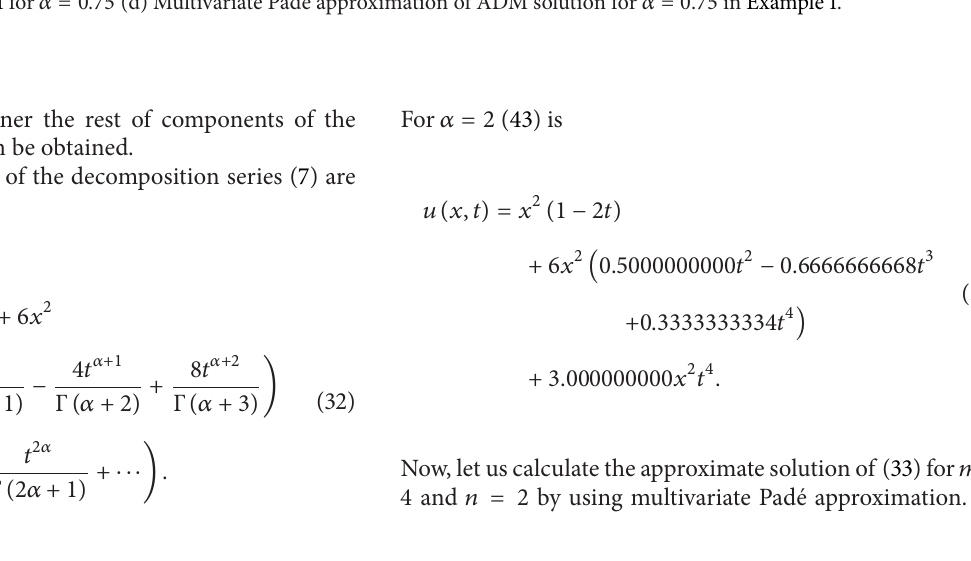
Figure 2: (a) ADM solution of Example 1 for 𝛼 = 0.5 (b) Multivariate Pad´e approximation of ADM solution for 𝛼 = 0.5 in Example 1 (c) ADM solution of Example 1 for 𝛼 = 0.75 (d) Multivariate Pad´e approximation of ADM solution for 𝛼 = 0.75 in Example